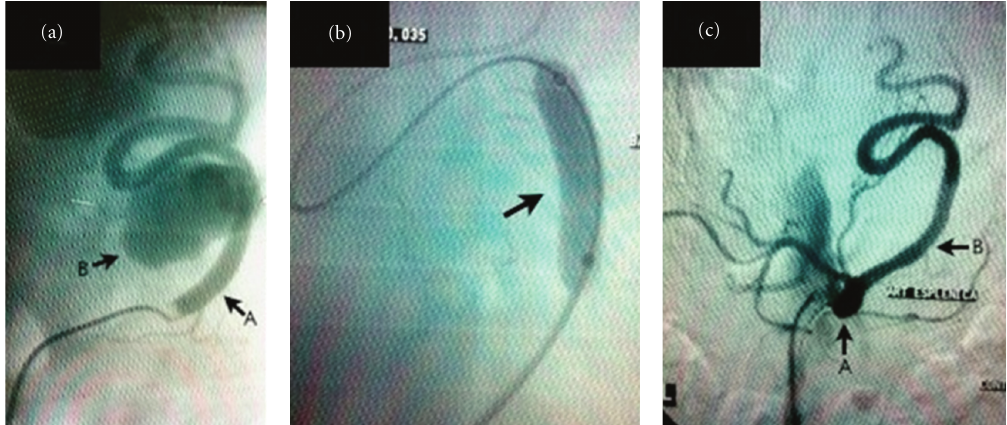
Figure 2: (a) Preoperative angiography. A: splenic artery, B: saccular aneurysm. (b) 6 × 40mm angioplasty balloon inflated to stent accommodation. (c) Control angiography showing absence of perfusion of the aneurysmal sac. A: celiac trunk, B: splenic artery.